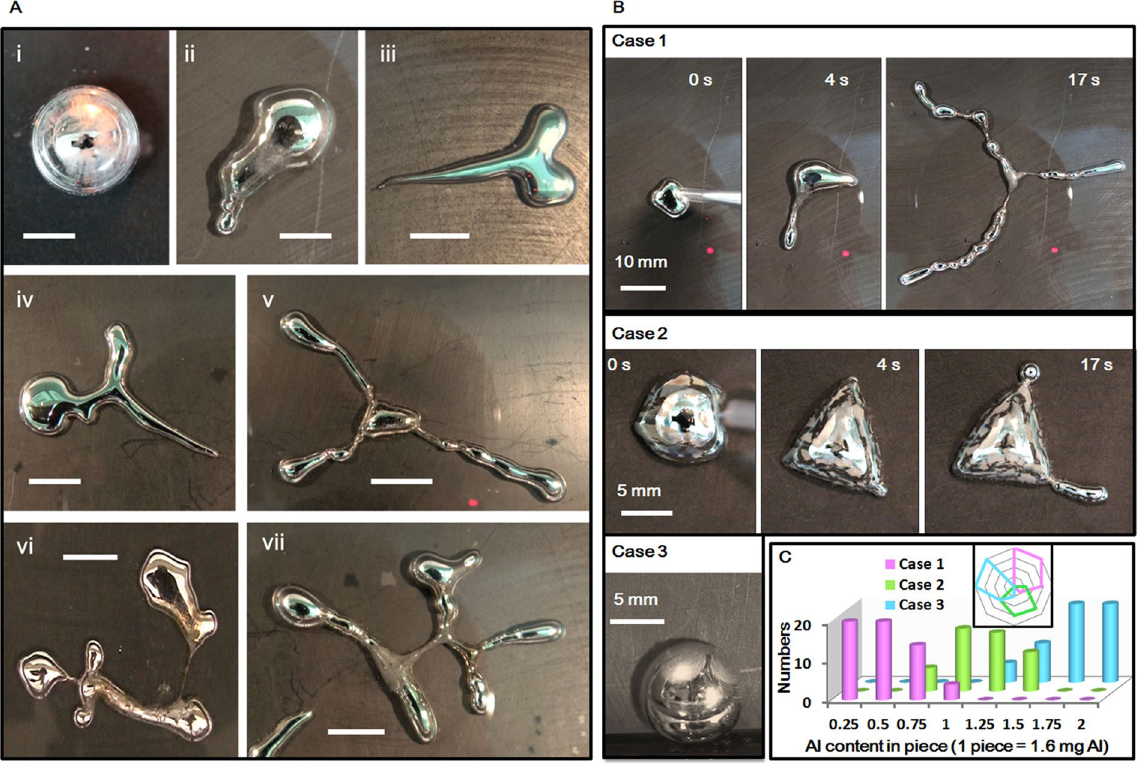
Figure 1. ( A ) i. The LM-Al droplet prepared in NaOH in glass petri dish. ii–vii. Amoeba-like transformations of LM-Al droplets on the graphite. The LM amoeba presents one main “pseudopodia” in ii, three in iii and iv, four in vi and five in vii. Scale bars: i and ii, 3 mm; iii and iv, 5 mm; v, 1 cm; vi and vii, 6 mm. ( B ) Consecutive snapshots of three typical heteromorphous transformation of LM-Al droplet in Case 1 to Case 3. ( C ) The LM droplets with various Al contents presenting different behaviors were categorized and numbered (20 trials for each content. For Al content, 1 piece = 1.6 mg). Inset: The radar plot of the data adapted from Fig.